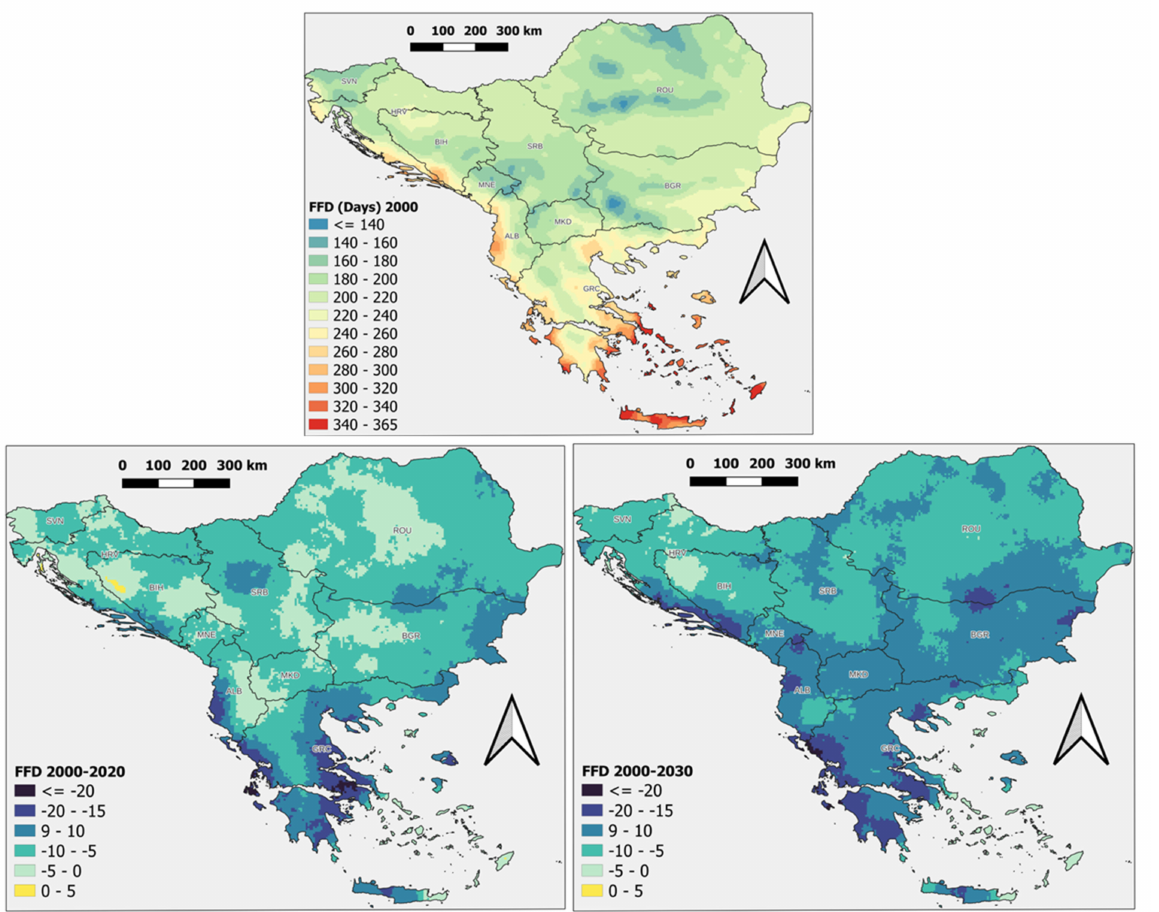
Figure 10. Free of Frost Days (FFD). Reference period ( upper image), the difference between the reference period and the 2020 horizon ( down left ) and the difference between the reference period and the 2030 horizon ( down right